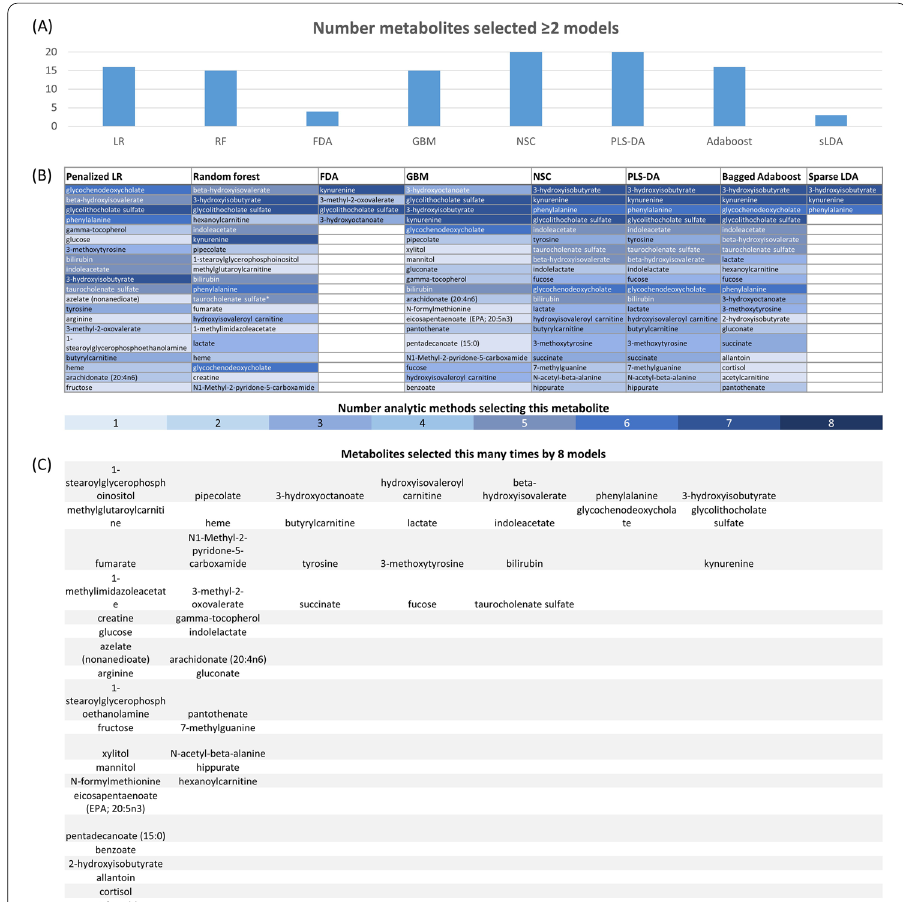
Fig. 2 Comparison of top metabolites selected by each analysis method’s innate feature selection algorithm. Comparison of top metabolites selected by each analysis method’s innate feature selection algorithm, identifying metabolites that more meaningfully contribute to successful sepsis mortality prediction models. Such approaches may identify measures of association and individual metabolic links with mortality. Agreement was noted between the lists of top metabolites identified by several machine learning methods, which also overlapped with those identified by conventional panelized logistic regression. FDA flexible discriminant analysis, GBM generalized boosted regression models, LR logistic regression, NSC nearest shrunken centroids, PLS-DA partial least squares‑discriminant analysis, sparse LDA sparse discriminant